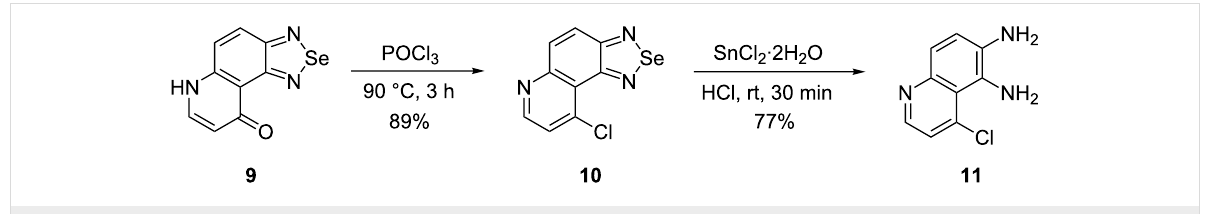
Scheme 3: Synthesis of 4-chloro-5,6-diaminoquinoline ( 11